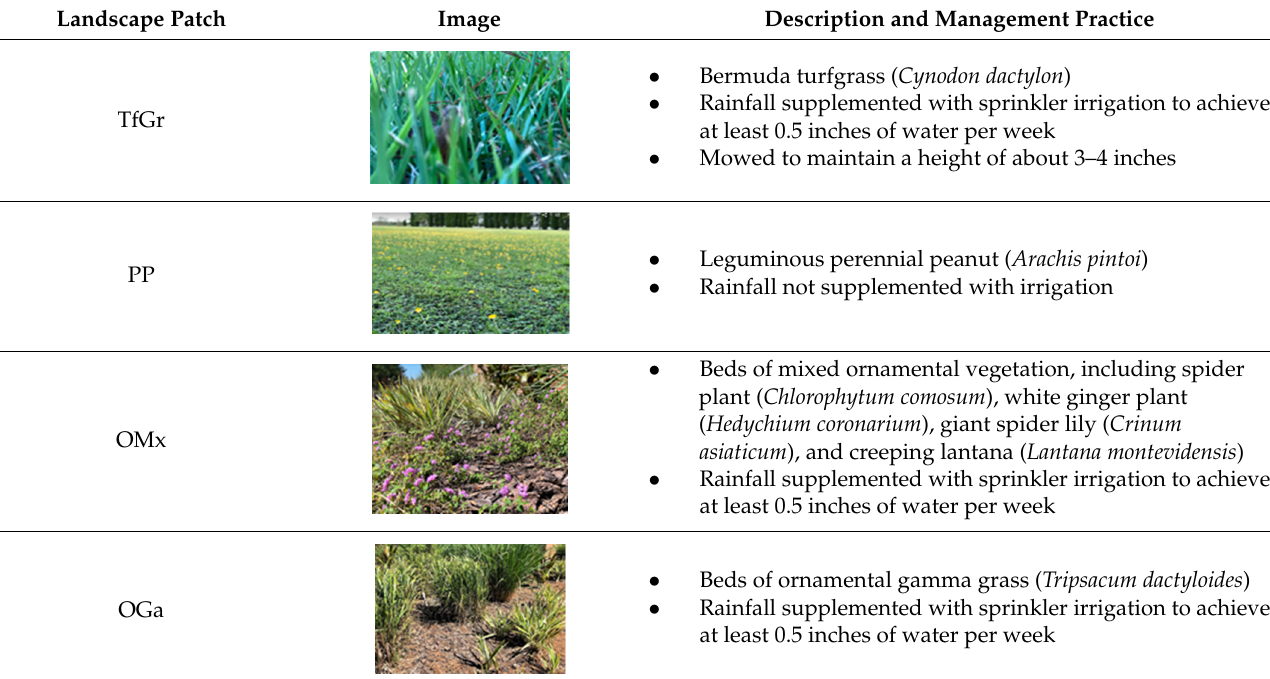
Table 1. Description of landscape patches .